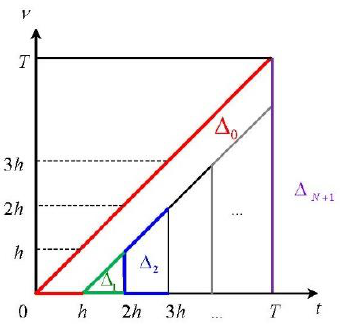
Figure 4. Geometric illustration of the location of the domains Δ 𝑘 .